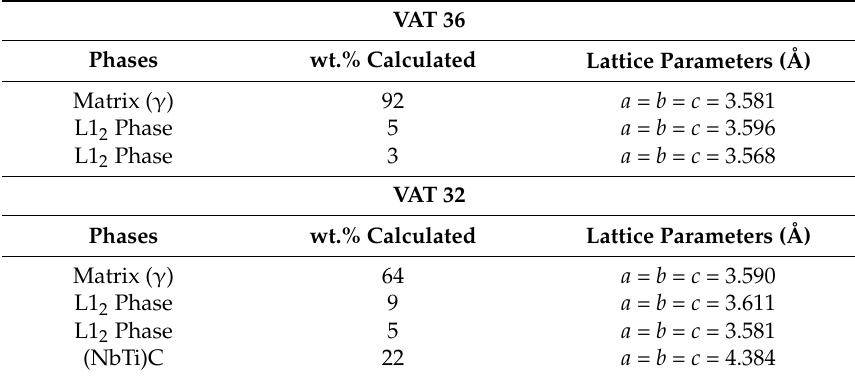
Table 4. Lattice parameters and percentages of the phases for the alloys VAT 36 and VAT 32.